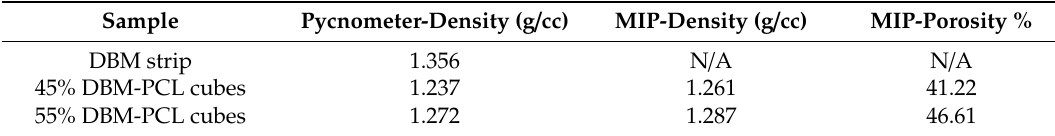
Table 3. The density and void volume fraction measured by